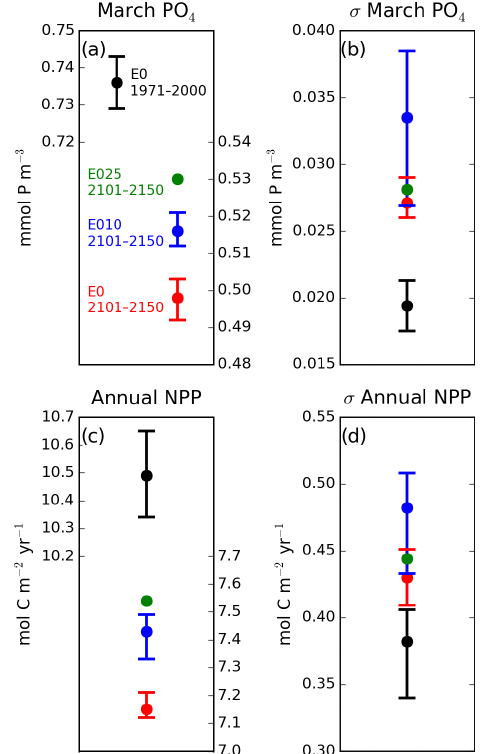
Figure 15. Mean (a, c) and standard deviation (b, d) of pre-bloom (March) phosphate concentration (a, b) and annual net primary pro- duction (c, d) in the northern North Sea (see Fig. 4) during historical conditions (E0, black) as well as the shallow-ML regime for exper- iments without (E0, red) and with 0.1Sv (E010, blue) and 0.25Sv (E025, green) GIS meltwater discharge. For E0 and E010, circle markers represent ensemble means; error bars illustrate ensemble spreads as the range between the minimum and maximum ensem- ble members. Exact values are given in Table